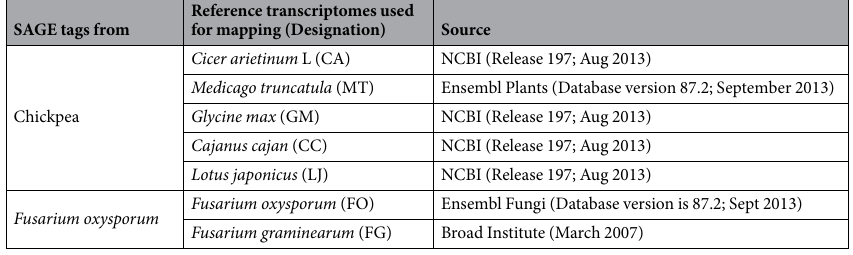
Table 3. Databases used for mapping SAGE tags in transcriptome